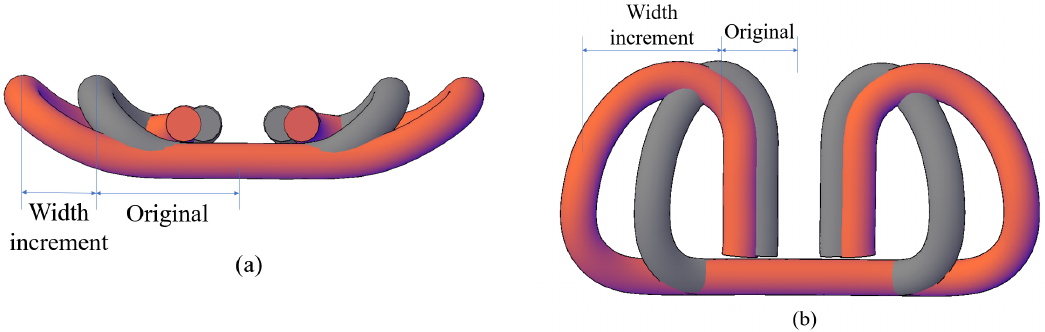
Figure 11. Perspective view of the change in the spring width: ( a ) front; ( b ) plan views.